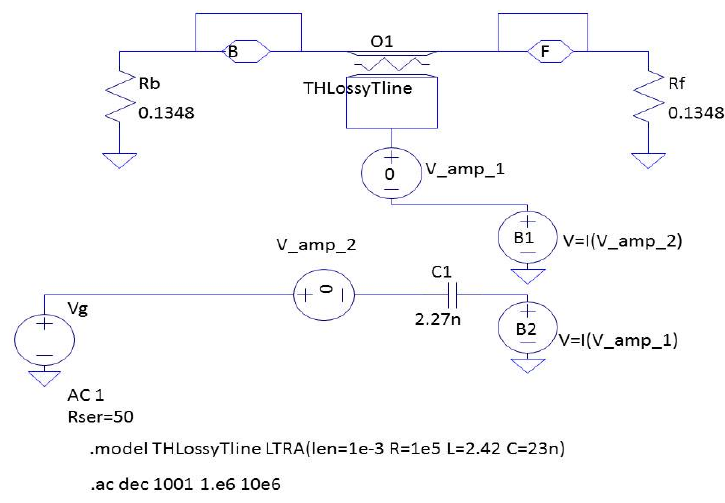
Figure 11. PSPICE schematic, which describes the equivalent circuit of a given device (under simulation) using a single piezoelectric element, represented by the lossy transmission line. Materials 2016 , 9 , 72